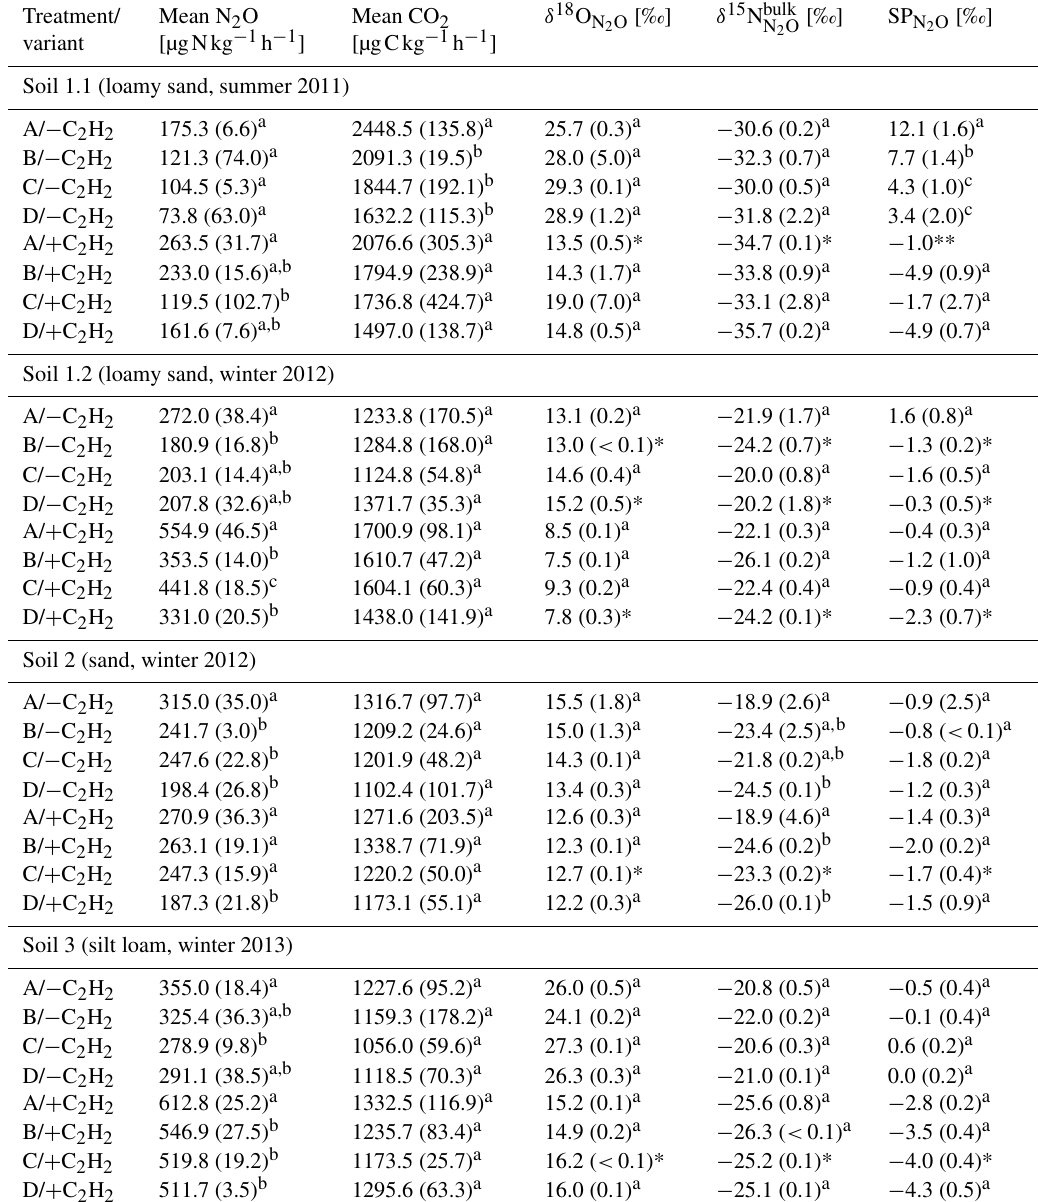
Table 2. Average CO 2 and N 2 O production rates and N 2 O isotopic values of N 2 O of the last sample collection with and without C 2 H 2 application in the headspace (variants − C 2 H 2 and + C 2 H 2 ) of each soil (Soil 1 to 3) for treatments A without growth inhibition, B with bacterial growth inhibition, C with fungal growth inhibition, and D with bacterial and fungal growth inhibition, respectively (standard deviation in brackets; n =